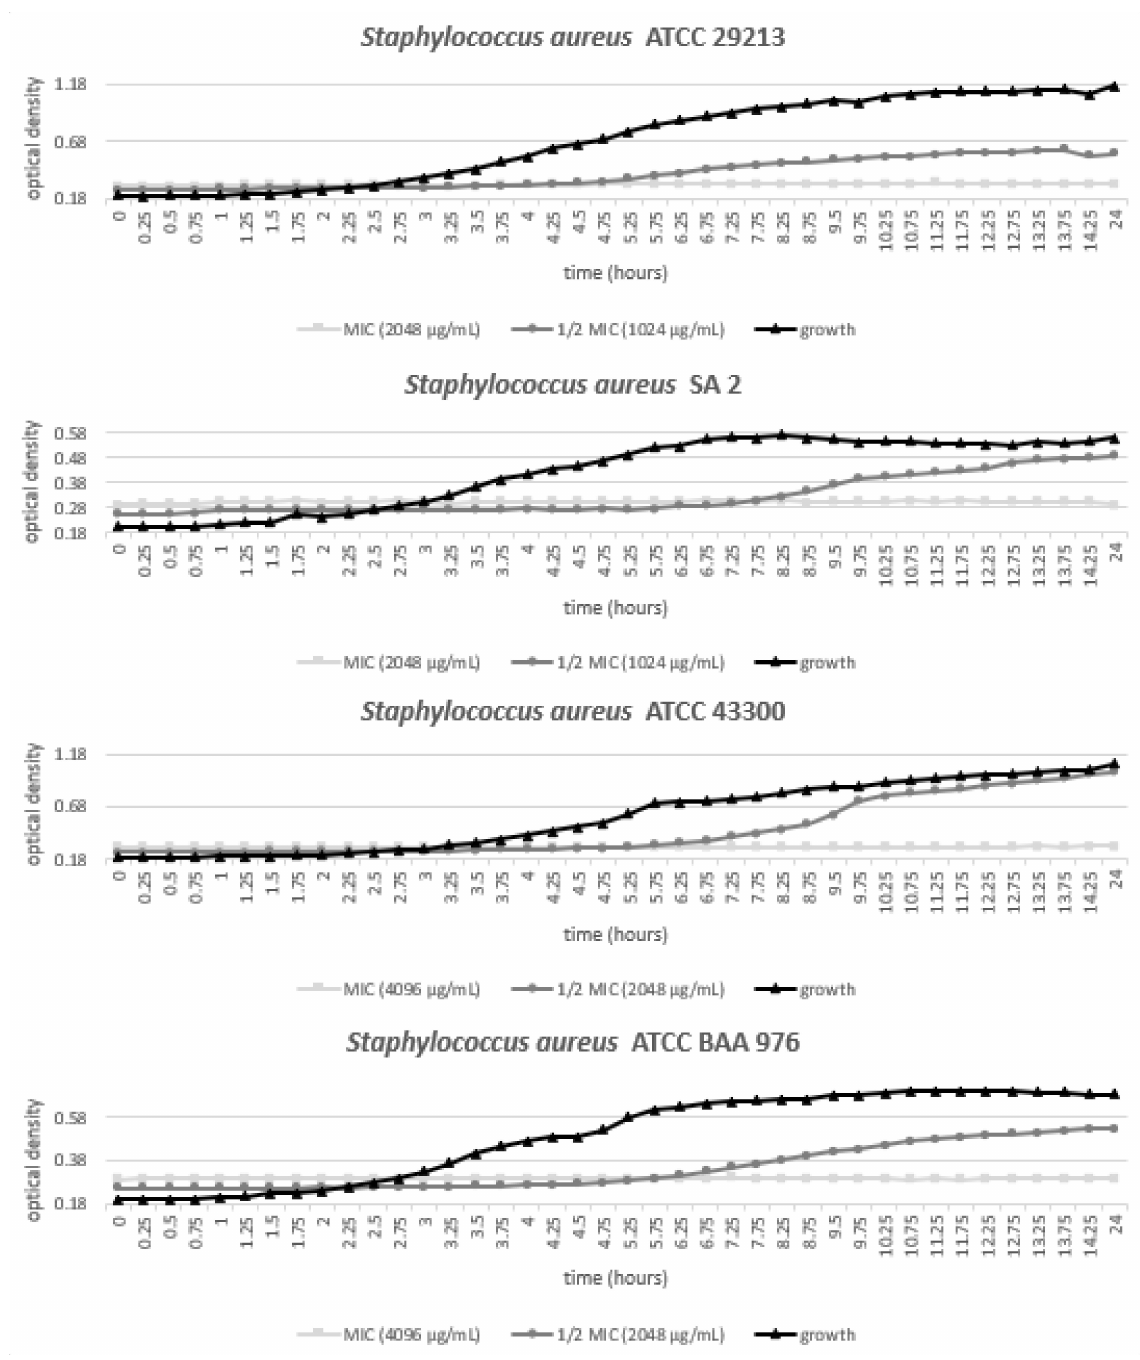
Figure 3. Growth curves of chosen Staphylococcus aureus ( S. aureus ) strains at two concentrations (minimum inhibitory concentration, MIC; half of minimum inhibitory concentration, 1 / 2 MIC) of methanolic extract of doenjang